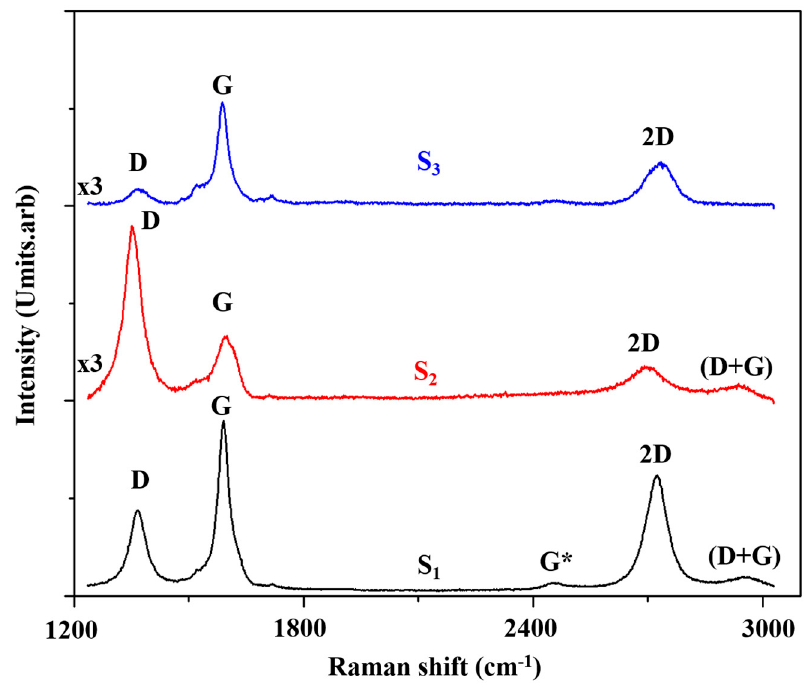
Figure 7. Raman spectra obtained randomly in different zones of three epitaxial graphene samples respectively: S 1 grown on 4H-SiC (0001), S 2 grown on 3C-SiC (100)/Si (100) and S 3 grown on 6H-SiC (0001). Major graphene Raman modes have been located.